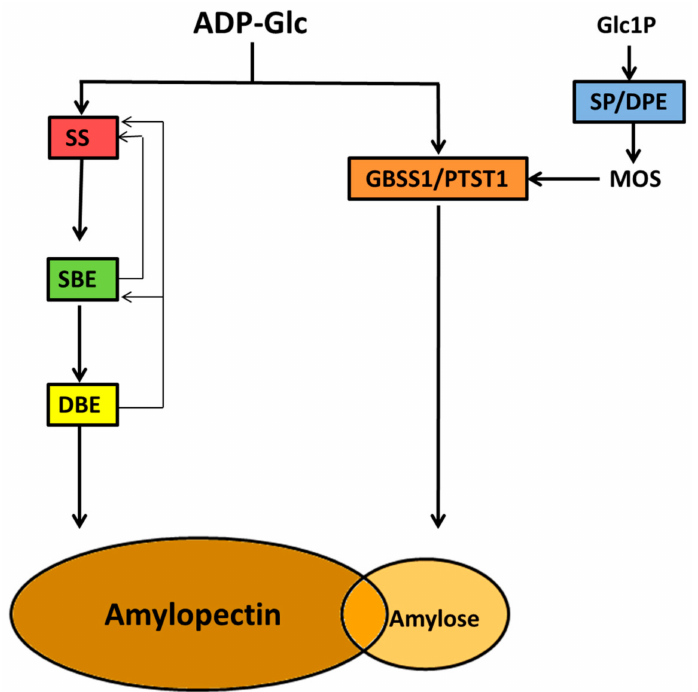
Figure 5. Generalized schematic of the pathway of starch biosynthesis following granule initiation and hilum formation showing the major enzyme classes (in boxes) responsible for granule